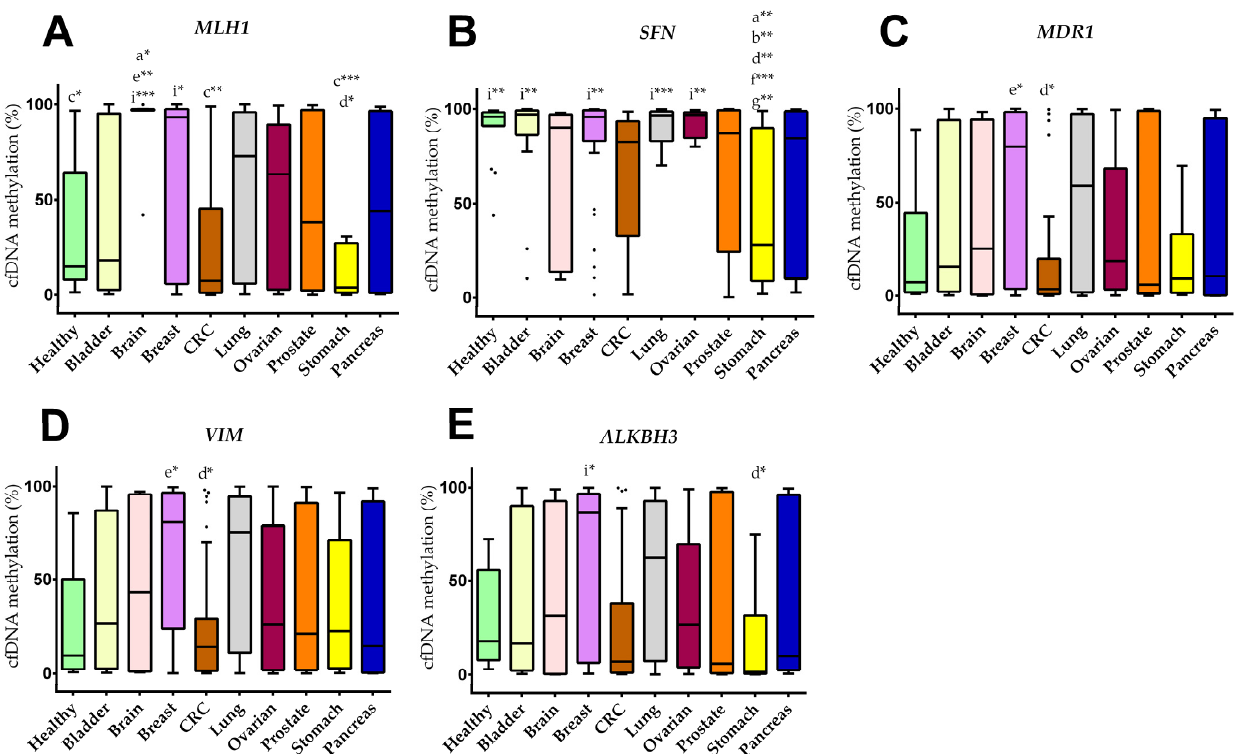
Figure 1. Cancer type specific cfDNA methylation levels. ( A – E ) Boxplots of cfDNA methylation for ( A ) MLH1 , ( B ) SFN , ( C ) MDR1 , ( D ) VIM , ( E ) ALKBH3 . Boxes are the 25th to 75th percentile; the line is the median, and whiskers are 1.5× IQR. p -values are showed as * p < 0.05; ** p < 0.005; *** p < 0.001. Lower case letters indicate the group with significantly different cfDNA methylation levels: a healthy, b bladder, c brain, d breast, e CRC, f lung, g ovarian, i